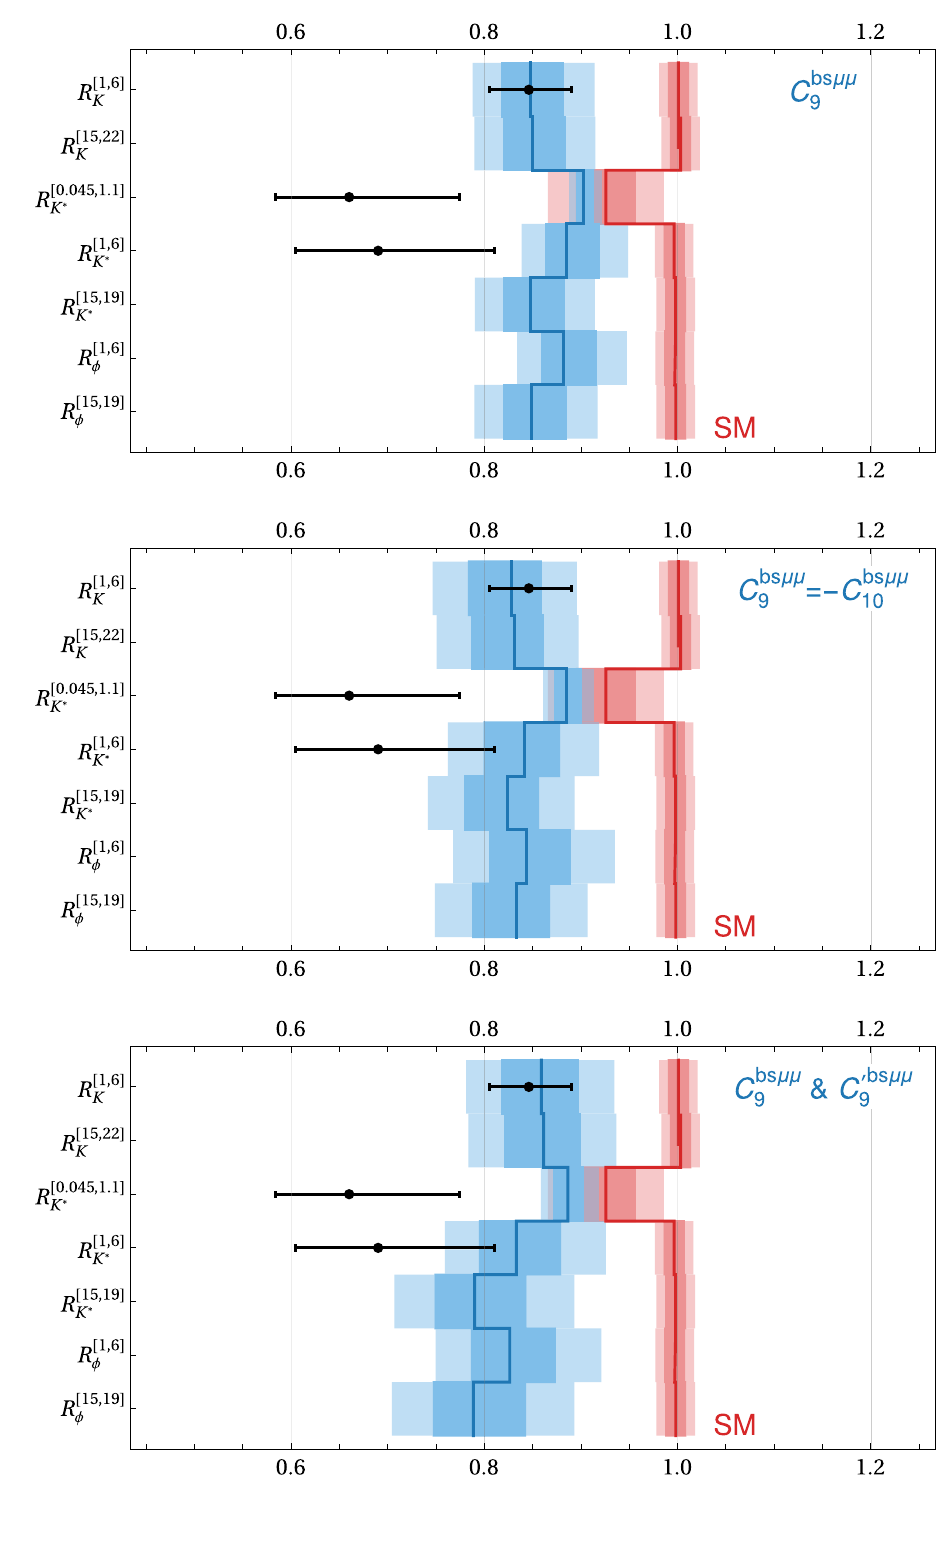
Fig. 8 Predictions for the LFU ratios R K , R K ∗ , and R φ in three new physics scenarios and the SM. For comparison the current measurements from LHCb [12,32] are shown as